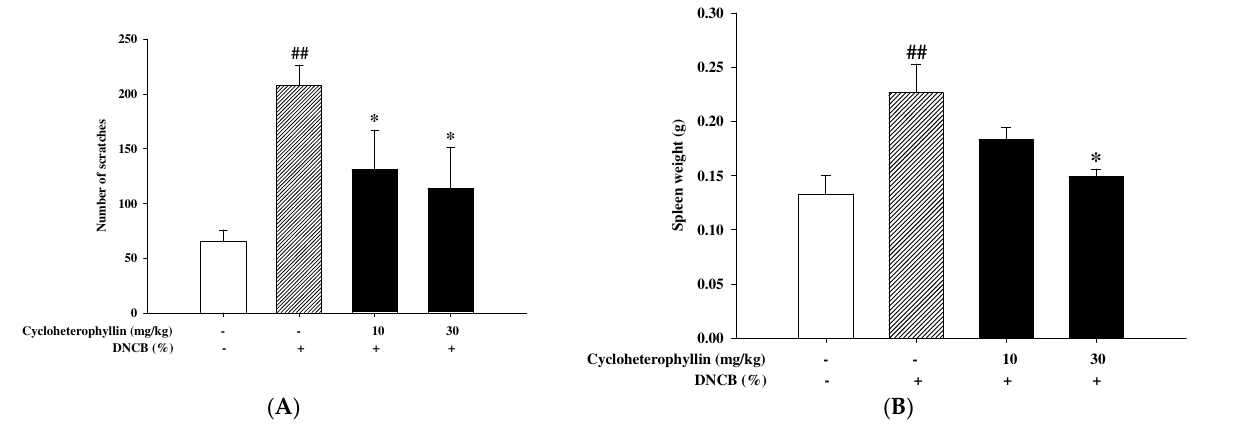
Figure 7. Effects of cycloheterophyllin on scratching and spleen enlargement in mice. ( A ) Analysis of changes in the number of scratches in BALB/c mice with atopic dermatitis-like appearance. ( B ) The effect of cycloheterophyllin on spleen weight. Values represent mean ± SEM from at least three independent experiments. ## p < 0.01 vs. untreated condition; * p < 0.05 vs. DNCB-induced group. 2.7. Effects of Cycloheterophyllin on Epidermal Thickness and Mast Cell infiltration in DNCB-